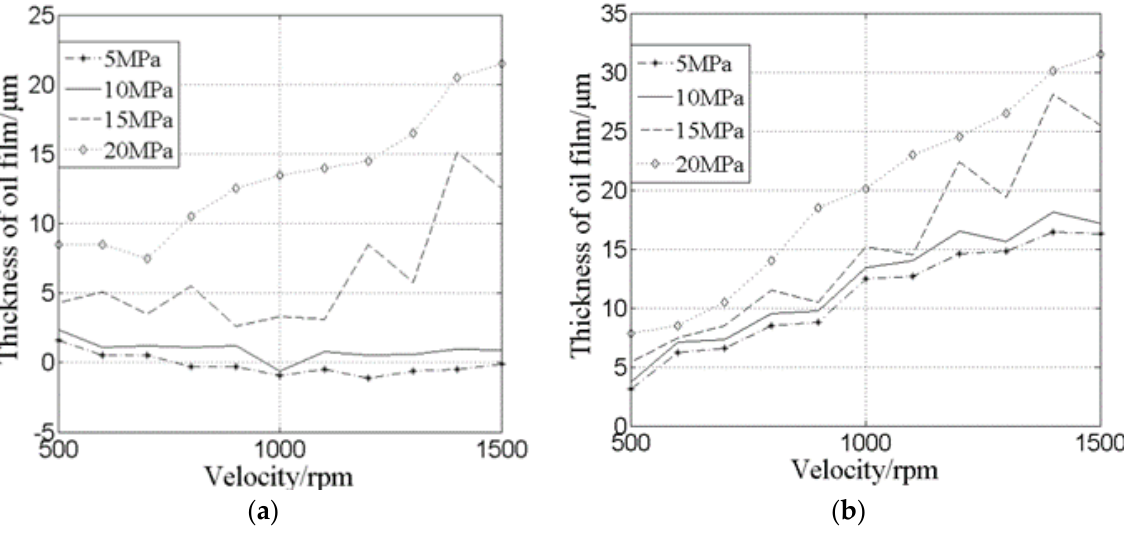
Figure 23. Oil film thickness statistics of the port plate pair. ( a ) The oil film thickness of the inlet; ( b ) the oil film thickness of the outlet.